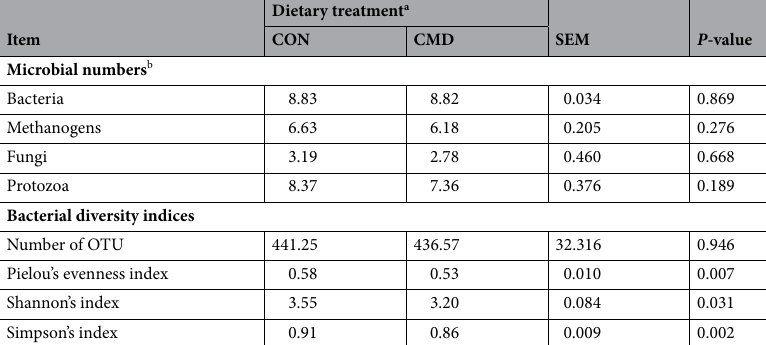
The correlation between the rumen bacterial community and ruminal FA profiles was elucidated on the CCA ordination plot (Fig. 2). There was a clear clustering between rumen samples from lambs fed CON and